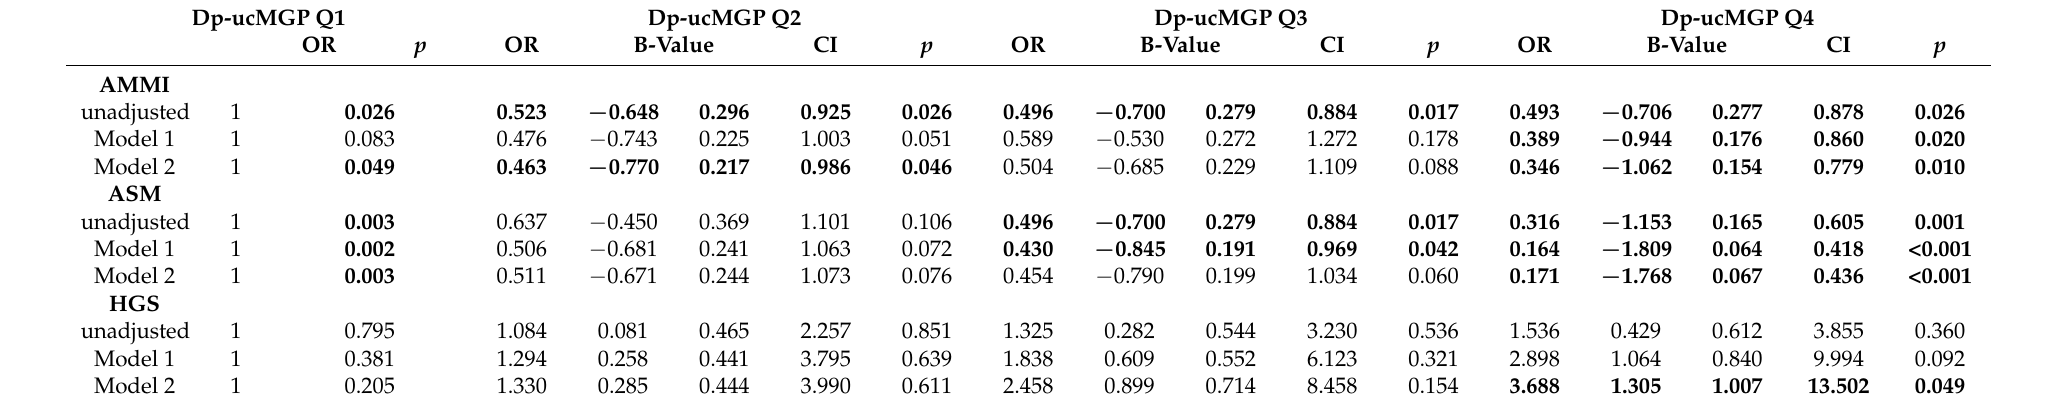
Table 5. Odds ratios for the association of dp-ucMGP quartiles with sarcopenia defined by AMMI, ASM or